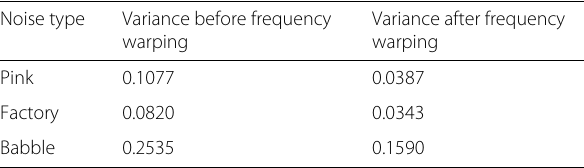
Table 14 Noise variance comparison before and after frequency warping and for different noise types